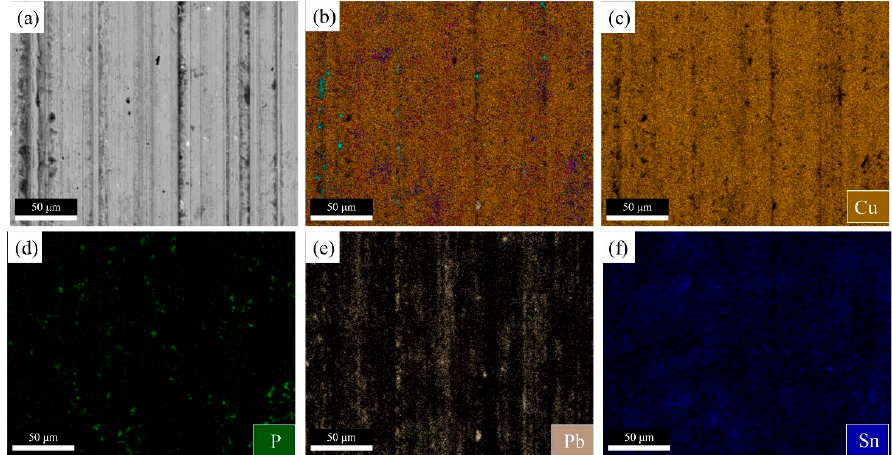
Figure 10. Map of copper layers wear scar with solidification temperature of 700 °C. ( a ) Copper layers BSE, ( b ) element distribution, ( c ) Cu, ( d ) P, ( e ) Pb, and ( f ) Sn. layers BSE, ( b ) element distribution, ( c ) Cu, ( d ) P, ( e ) Pb, and ( f )